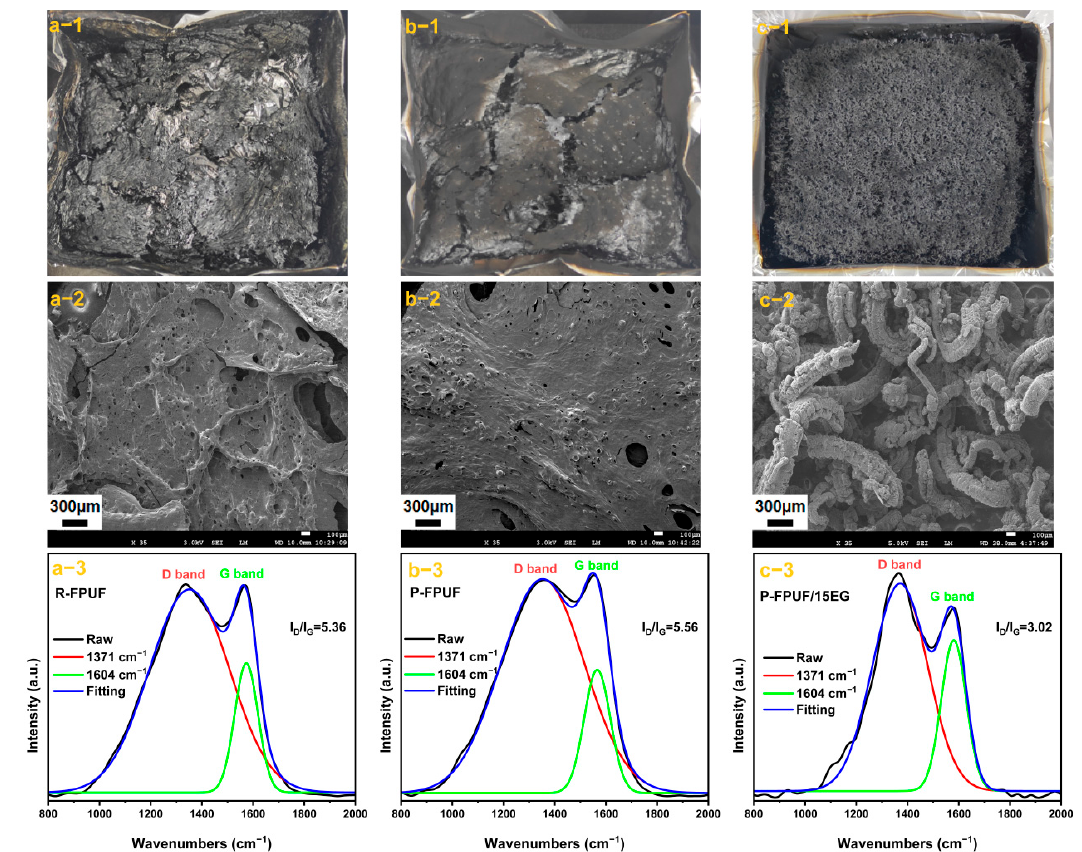
Figure 11. Morphology of the char residues and Raman spectroscopy of R-FPUF ( a–1 ~ a–3 ), P-FPUF